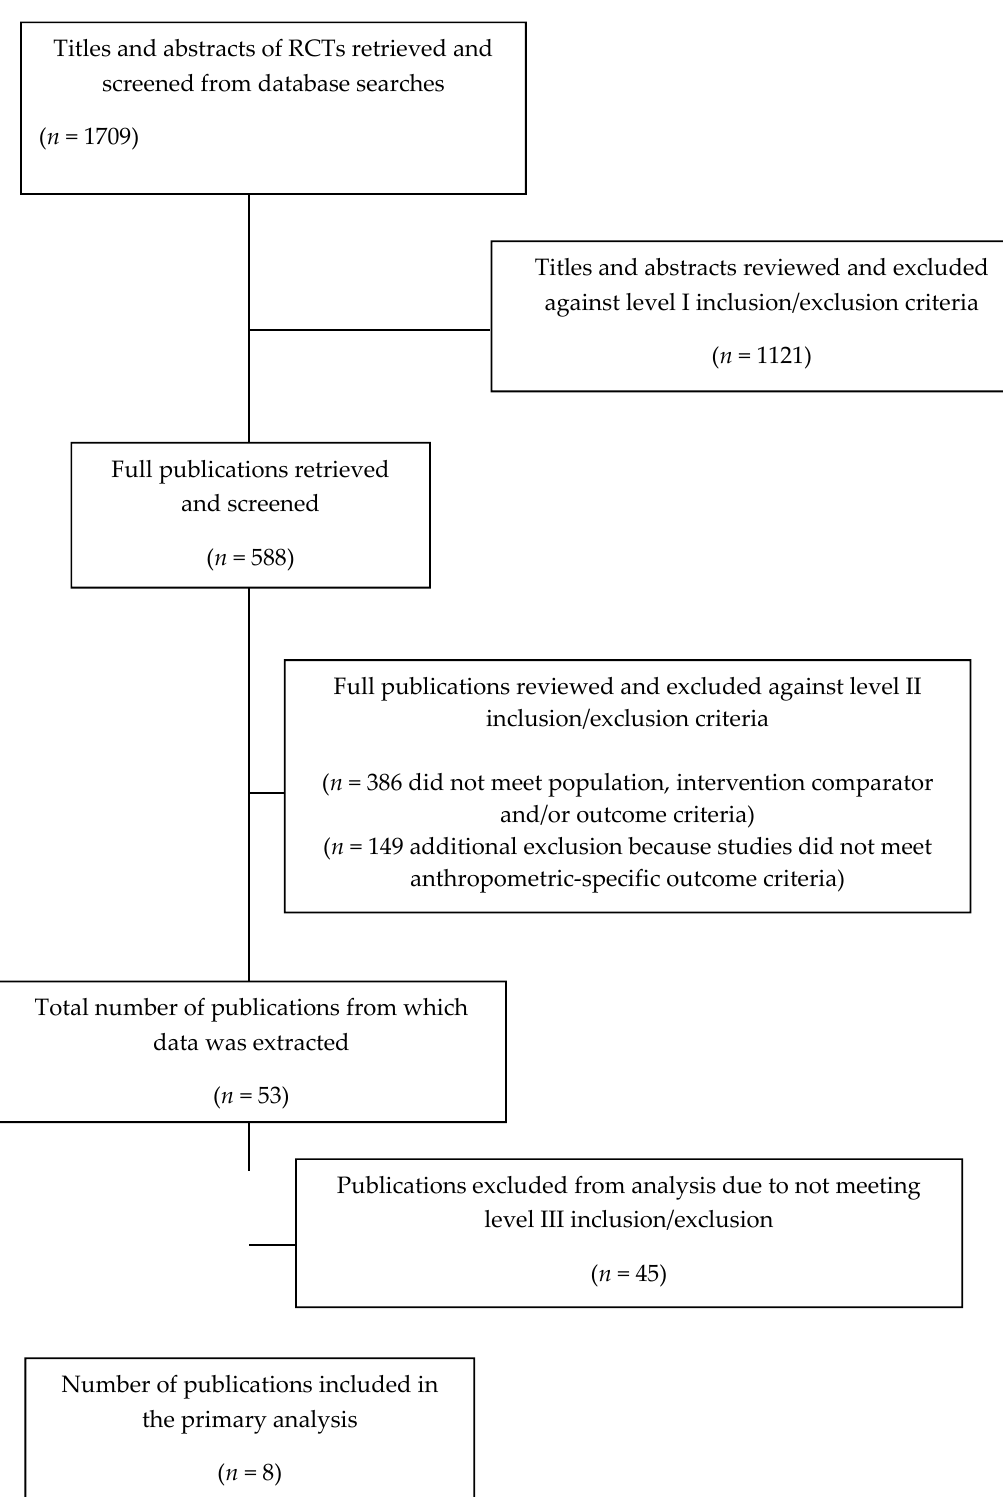
Figure 2. Flow diagram of literature search for RCT analyses inclusion.